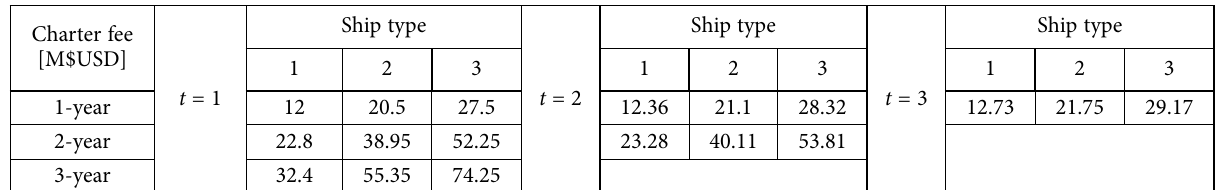
Table 2. Charter fee by ship type